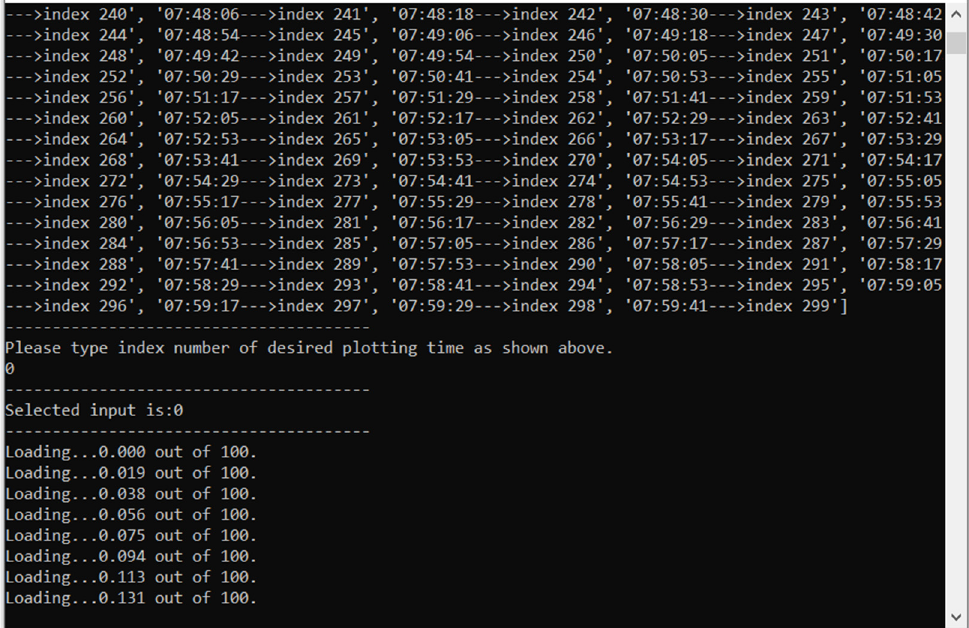
Figure 36. Screenshot of software.